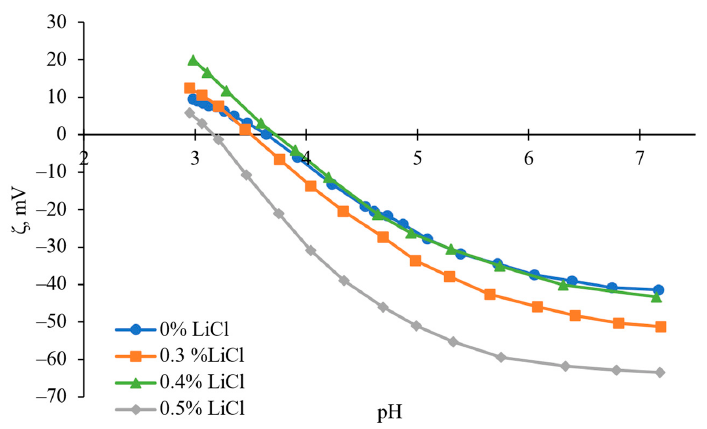
Figure 8. The zeta potential curves of prepared membranes were recorded using a SurPASS electro- kinetic analyser with the adjustable gap cell method and using 0.001 M KCl solution as an electro-